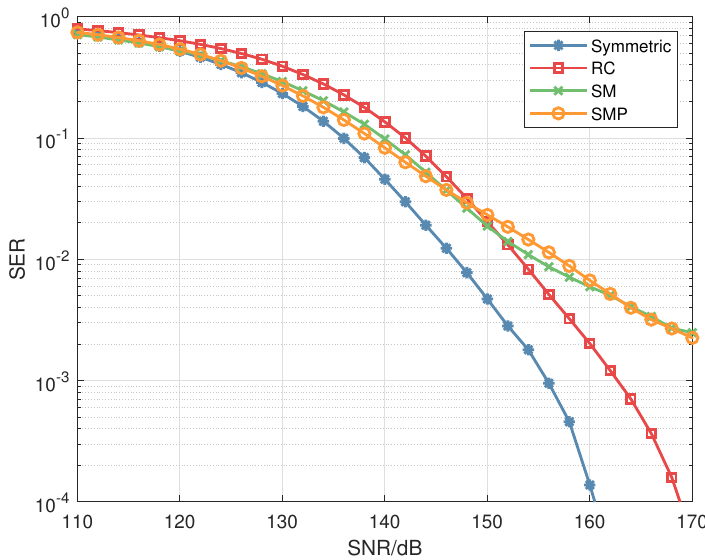
Figure 8. Reliability performance comparisons for the air–water interface